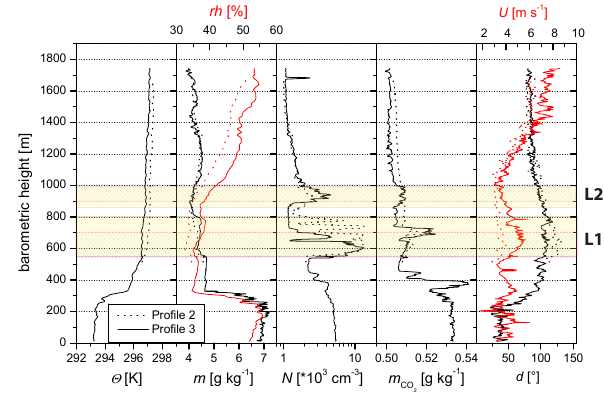
Fig. 4. Vertical profiles 2 and 3 (see Fig. 1) of the same parameters as shown in Fig. 3 but measured about one hour after the first profile. For this profiles, also mean wind speed U and direction d were